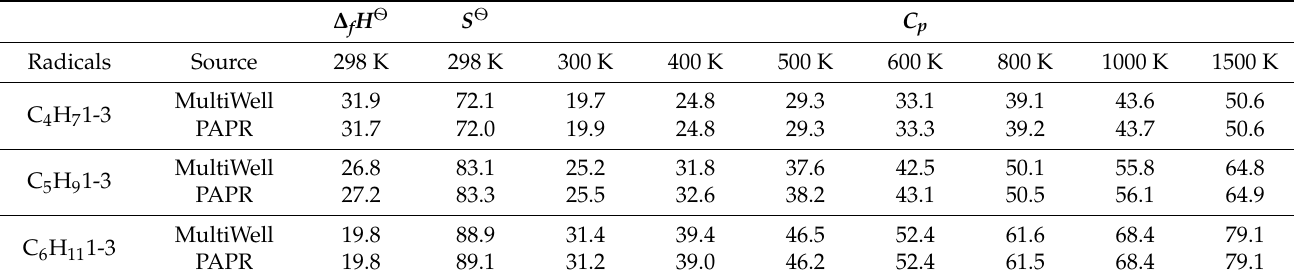
Table 5. Thermochemistry comparison of closed shell molecules. (Units: kcal mol –1 for ∆ f H Ө , cal K − 1 mol − 1 for S Ө and C p .) ∆ f H Ө S Ө C p Molecules Source This study C 4 H 6